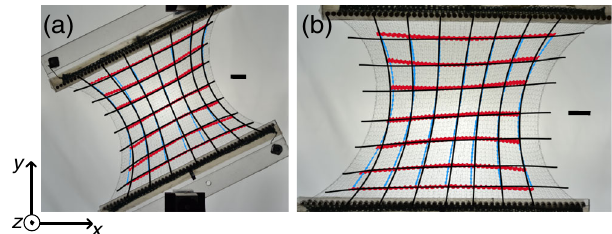
FIG. 8. Predicted and experimental deformations of a stretched fabric under two different loading configurations. In panel (a), the fabric is initially tilted by 25°, and in panel (b), the fabric is initially sheared along the x direction by an angle of 10°. The parameters c (cid:2) , w (cid:2) , δ , and thus β are the same as for the fabric used in Fig. 7(a). The boundary conditions of these configurations are shown in Appendix D. The applied strain is ε ¼ 11% for both fabrics, and scale bars in the panels are 2